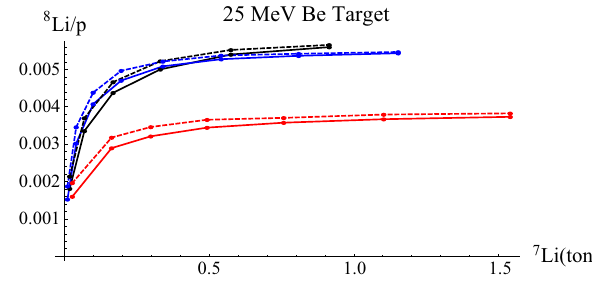
Fig. 8 The 8 Li yield per 25 MeV proton as a function of the 7 Li mass. The black, blue and red curves correspond to LiOD, LiOD · D 2 O and the solution respectively. The solid (dashed) curves correspond to a room